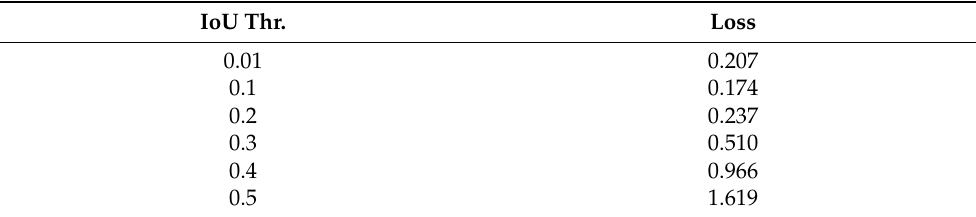
Table 1. Loss values of our insect-counting algorithm with conventional NMS. IoU